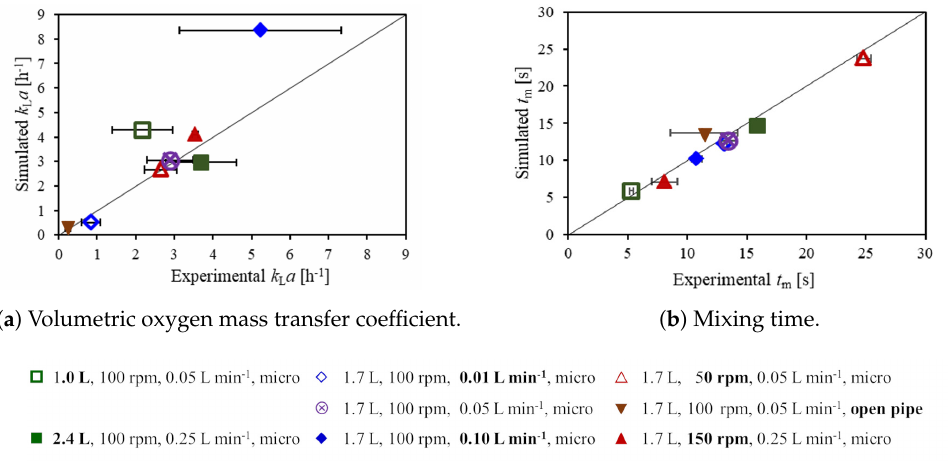
Figure 6. Volumetric oxygen mass transfer coefficient k L a ( a ) and mixing time t m ( b ). Horizontal error bars indicate the standard deviation of the experimental